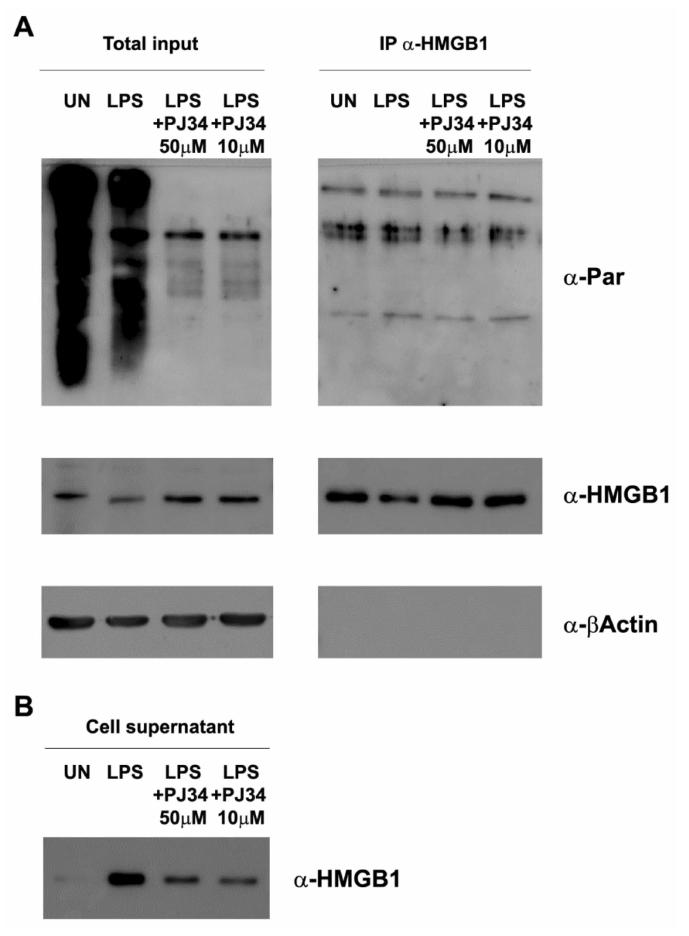
Figure 6. PARP1 favors HMGB1 PARylation promoting HMGB1 release. ( A ) Immunoprecipitation and Western blot of HMGB1 in RAW264.7 cells treated with LPS or cotreated with LPS and PJ34. Protein lysates were immunoprecipitated with anti-HMGB1 antibody followed by immunoblotting with anti-Par antibody, anti-HMGB1 or anti- β Actin as a negative control of IP. ( B ) Western blot of HMGB1 in cell supernatant of RAW264.7 cells treated with LPS or cotreated with LPS and PJ34. The experiment was performed in